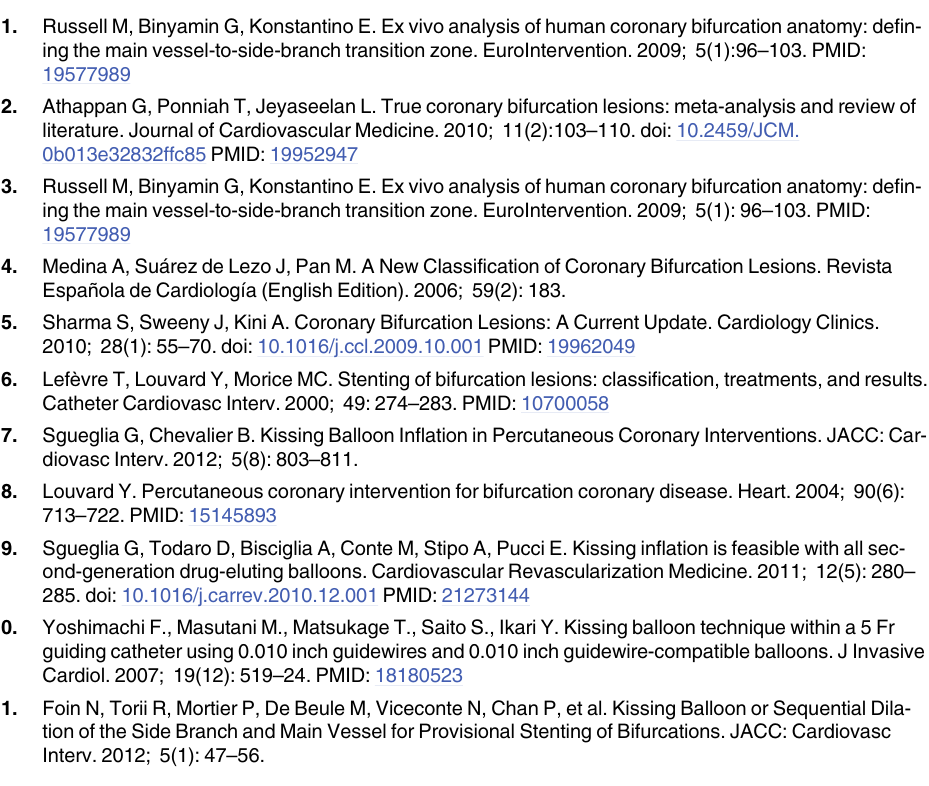
S1 Fig. Details of the principal log strain observed in the study. S2 Fig. Details of the principal log strain observed in the study with Tram 4 connections. S3 Fig. Details of the principal log strain observed in the study with Tram 3 connections and side-branch